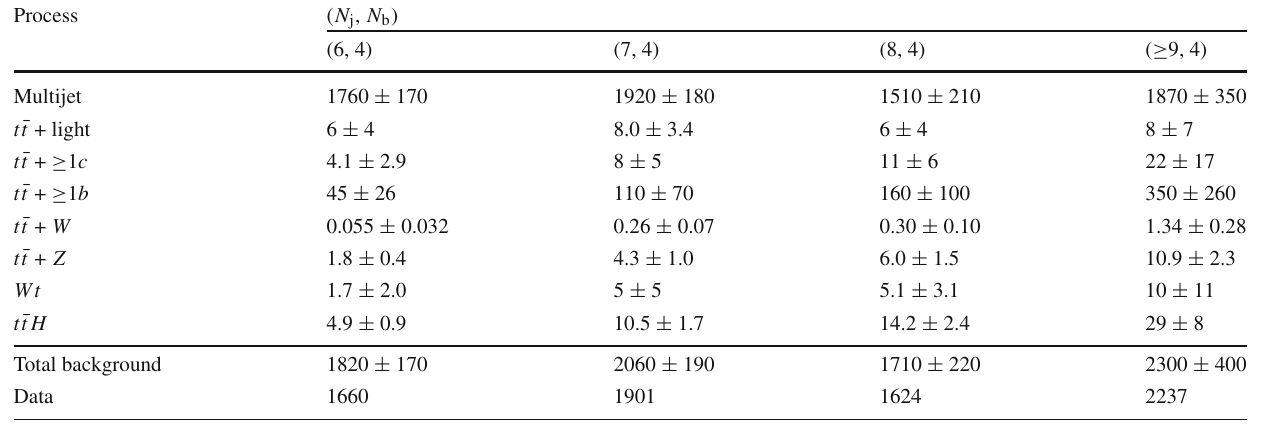
Table 3 Event yields from background predictions and data in the regions with N j = 6, 7, 8 or ≥ 9 and N b = 4. The quoted uncertainties are the sum in quadrature of the statistical and systematic uncertainties